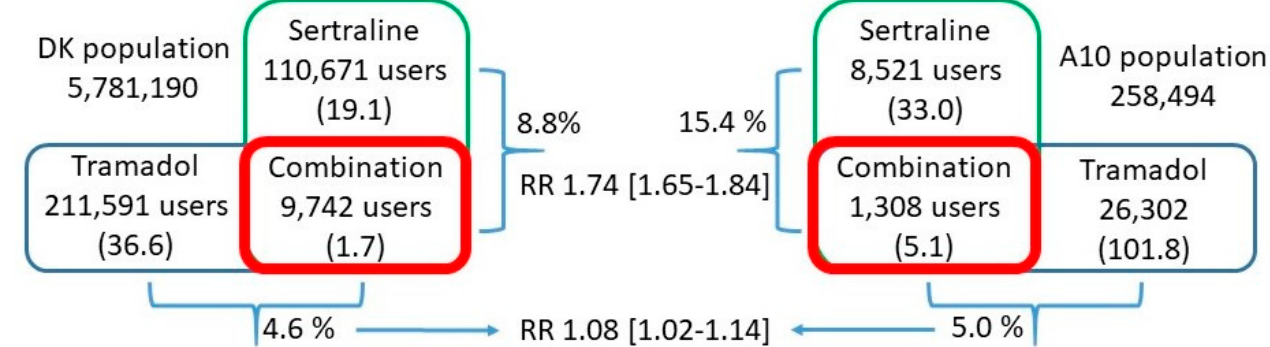
Figure 1. Prevalences of use and relative risks. Note: This figure illustrates the use of sertraline and tramadol either alone or in combination in the general population and among persons with diabetes. Numbers in brackets are prevalence (number of users/1000). Numbers in square brackets are relative risks (RR).